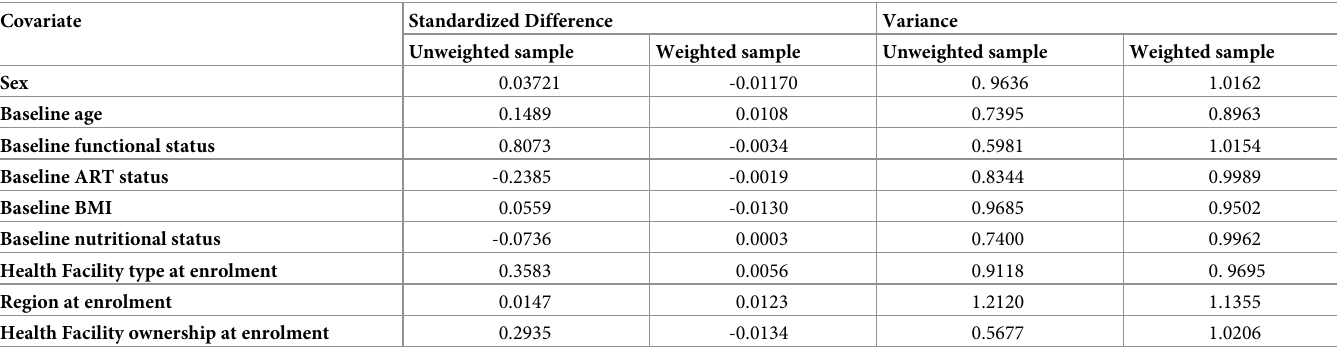
Table 2. Balance between unweighted and weighted samples after Inverse Probability of Treatment Weighting.